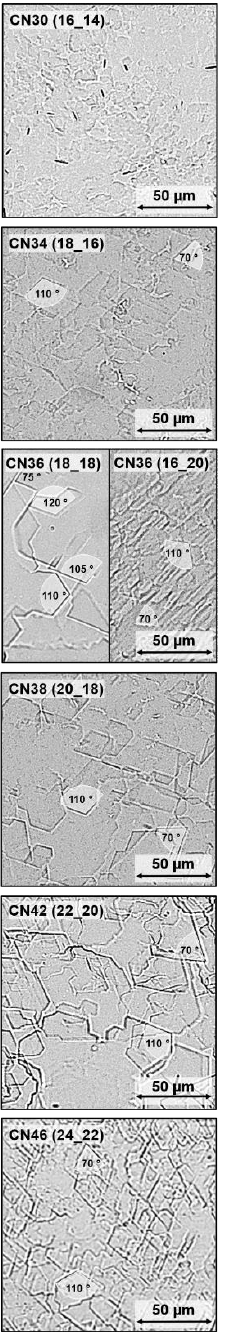
Figure 7. Bright field microscopy (BFM) images of oleogels containing MCT oil and 10% [ m / m ] of WE of different CN, indicated in the respective BFM micrograph. Cooling rate: 5 K/min. All WE are denoted as CN